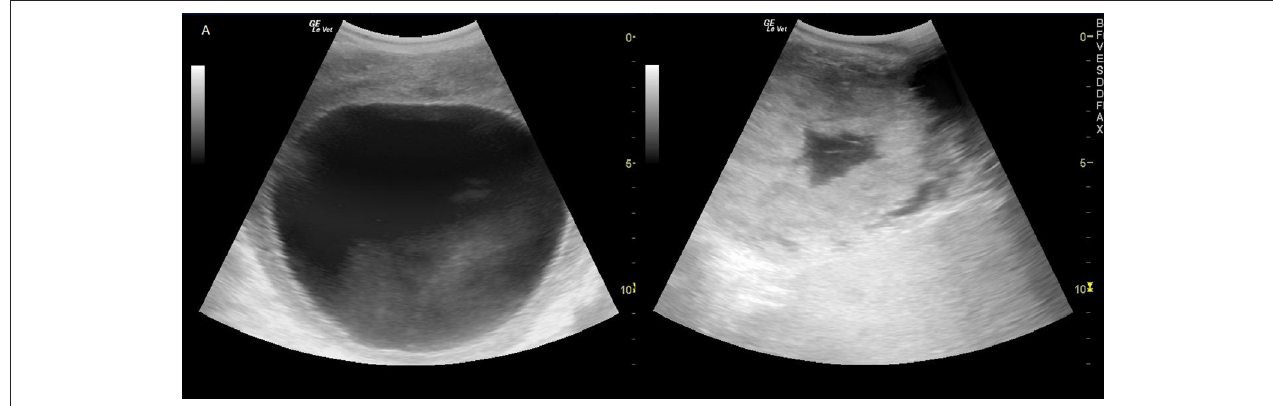
FIGURE 1 | Left: Preovulatory follicle of ∼ 11cm in a greater one-horned rhinoceros. Right: Ruptured follicle with blood filled center shortly 48h after ovulation induction.